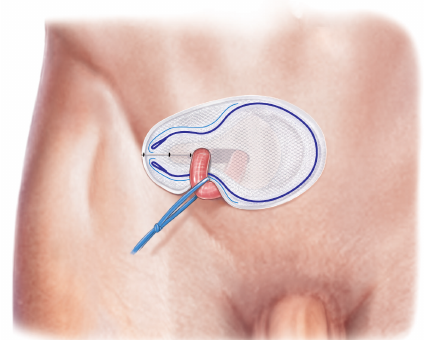
Figure 10: The two tails in the Onflex mesh are closed with nonabsorbable interrupted sutures.